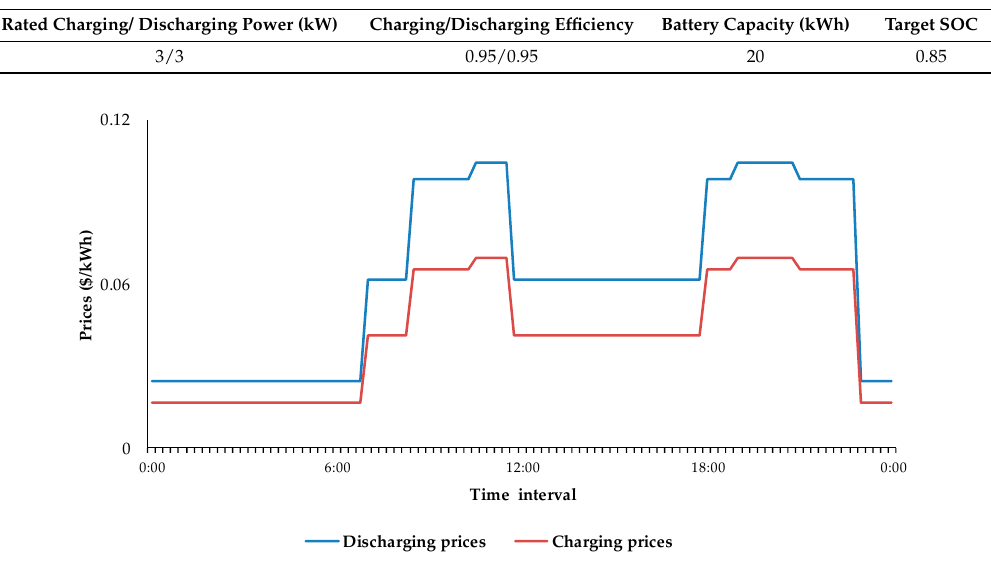
Table A2. Parameters of each EV.